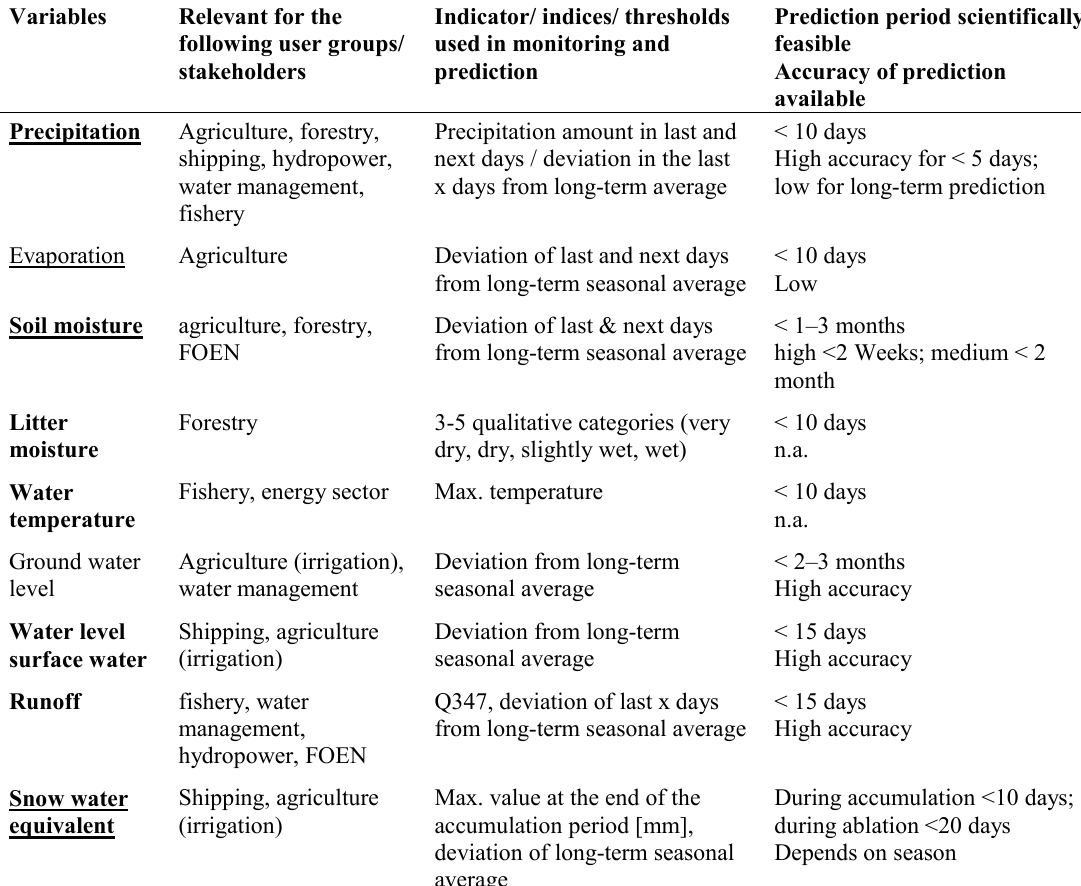
Table 1 Variables for the early recognition of droughts from the perspective of user groups and availability of information (adapted and reduced from Kruse and Seidl 2013). Bold variables have been implemented in www.drought.ch for monitoring purposes at the Swiss scale. Underlined variables have been implemented for three catchments in forecasting mode and compared to seasonal model climatology. Q347 is a threshold indicating the minimal discharge that needs to be reached or passed for more than 347 days per